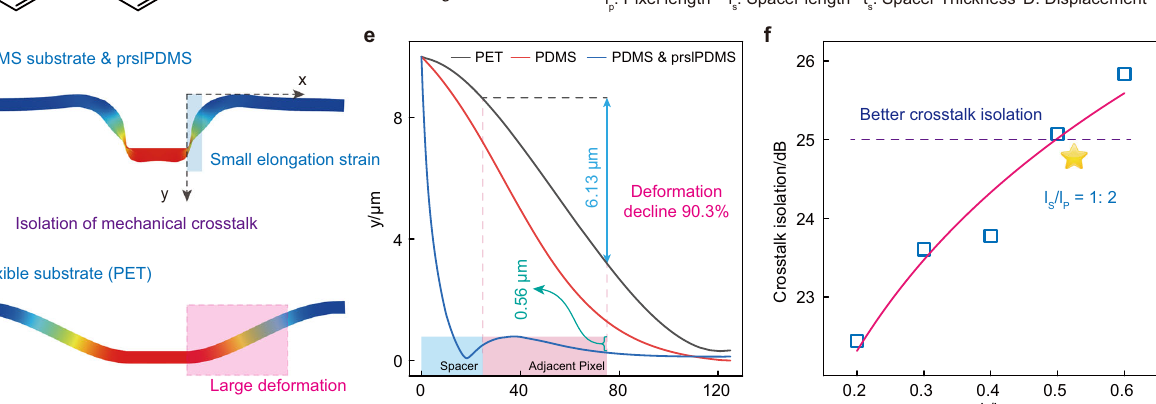
& prslPDMS and PET under external pressure, and the micro-cage structure of the formerenablesthesmallelongationstraincomparedwiththelatter. e Quantitative analysis of displacement variation along the x-axis for different models, and the displacement of adjacent pixel using prslPDMS layer decrease by 90.3% compared with PET. f Crosstalk isolation versus the ratio of spacer length to pixel length, the better isolation effect could be achieved when its value is greater than